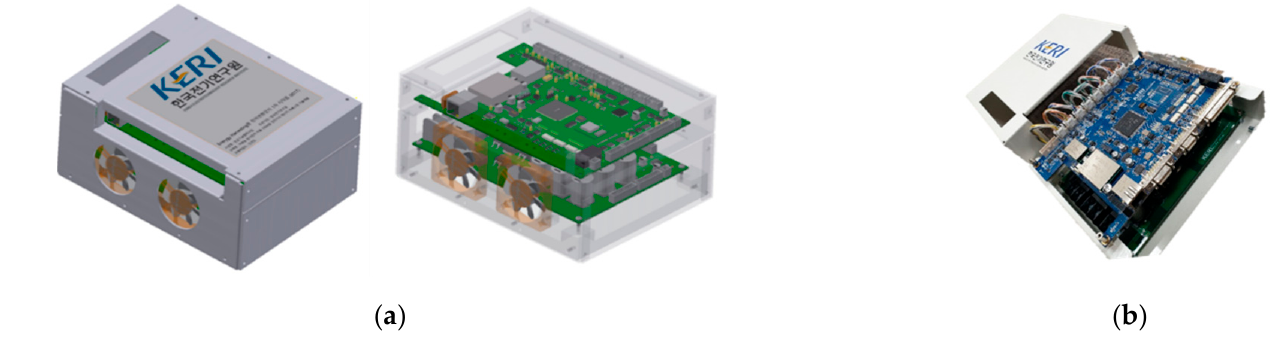
Figure 8. Overall power converter final prototype: ( a ) 3D model; ( b ) power converter final prototype.